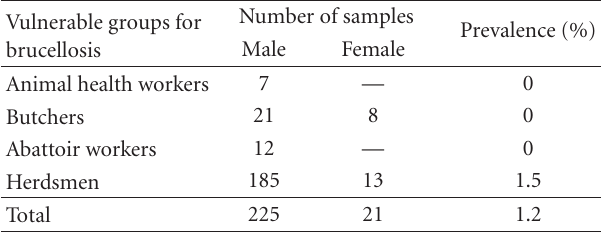
Table 5: Seroprevalence of brucellosis in human risk groups of Western Tigray, North Western Ethiopia, October 2007 to February